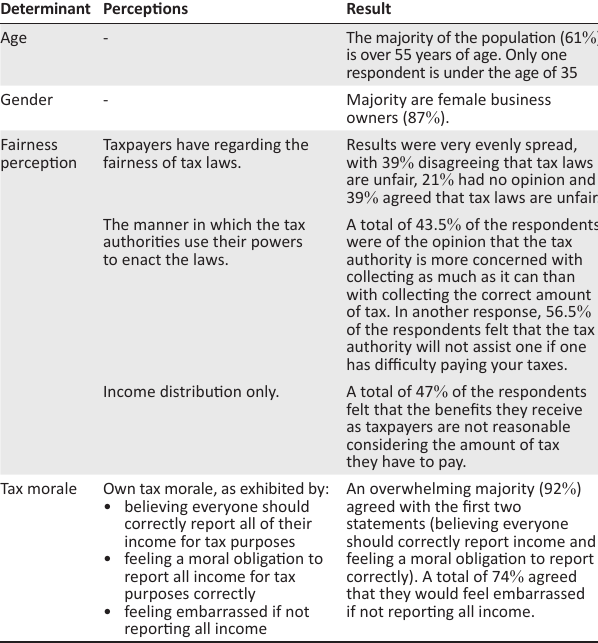
TABLE 1: Results of the analysis for the population surveyed using the factor ‘Person’. Determinant